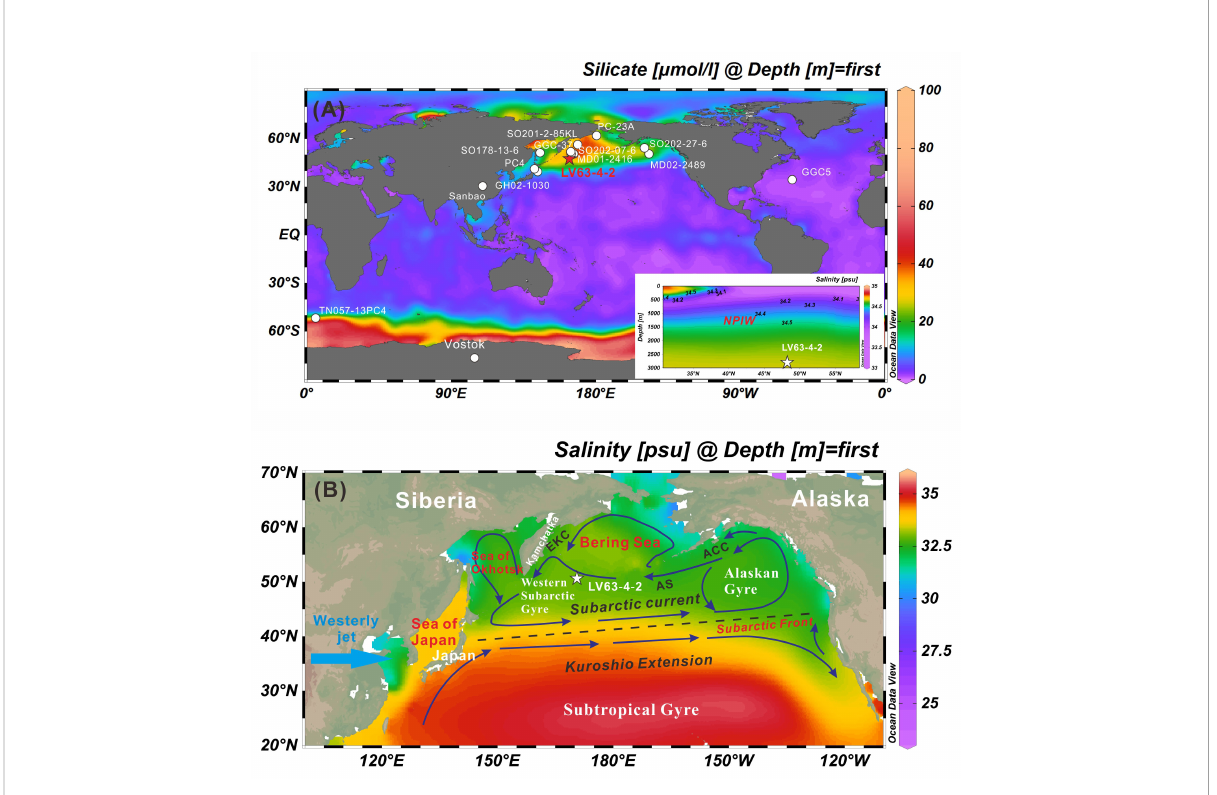
FIGURE 1 Locations of the cores that were referred to in this paper and the modern regional settings in the study area. (A) Global map of the mean annual silicic acid concentration. The sediment cores are from the following locations: (i) the subarctic Paci fi c Ocean LV63-4-2 (this study), GGC-37 (Lam et al., 2013), MD01-2416 (Gebhardt et al., 2008), SO202-27-6 (Maier et al., 2015), and MD02-2489 (Rae et al., 2014); (ii) the Bering Sea SO201-2-85KL (Max et al., 2014) and PC-23A (Rella et al., 2012); (iii) the Sea of Okhotsk SO178-13-6 and PC4 (Hoshiba et al., 2006); and (iv) other GH02-1030 (Okazaki et al., 2010), GGC05 (McManus et al., 2004), and TN057-13PC4 (Anderson et al., 2009). Map of the salinity distribution of intermediate water in the North Paci fi c in the right corner (B) Mean annual sea surface salinity (Antonov et al., 2010) and ocean surface currents (after Dodimead et al., 1963; Stabeno et al., 2004); abbreviations: ACC, Alaska Coastal Current; AS, Alaskan Stream; EKC, East Kamchatka Current. The maps were created using Ocean Data View